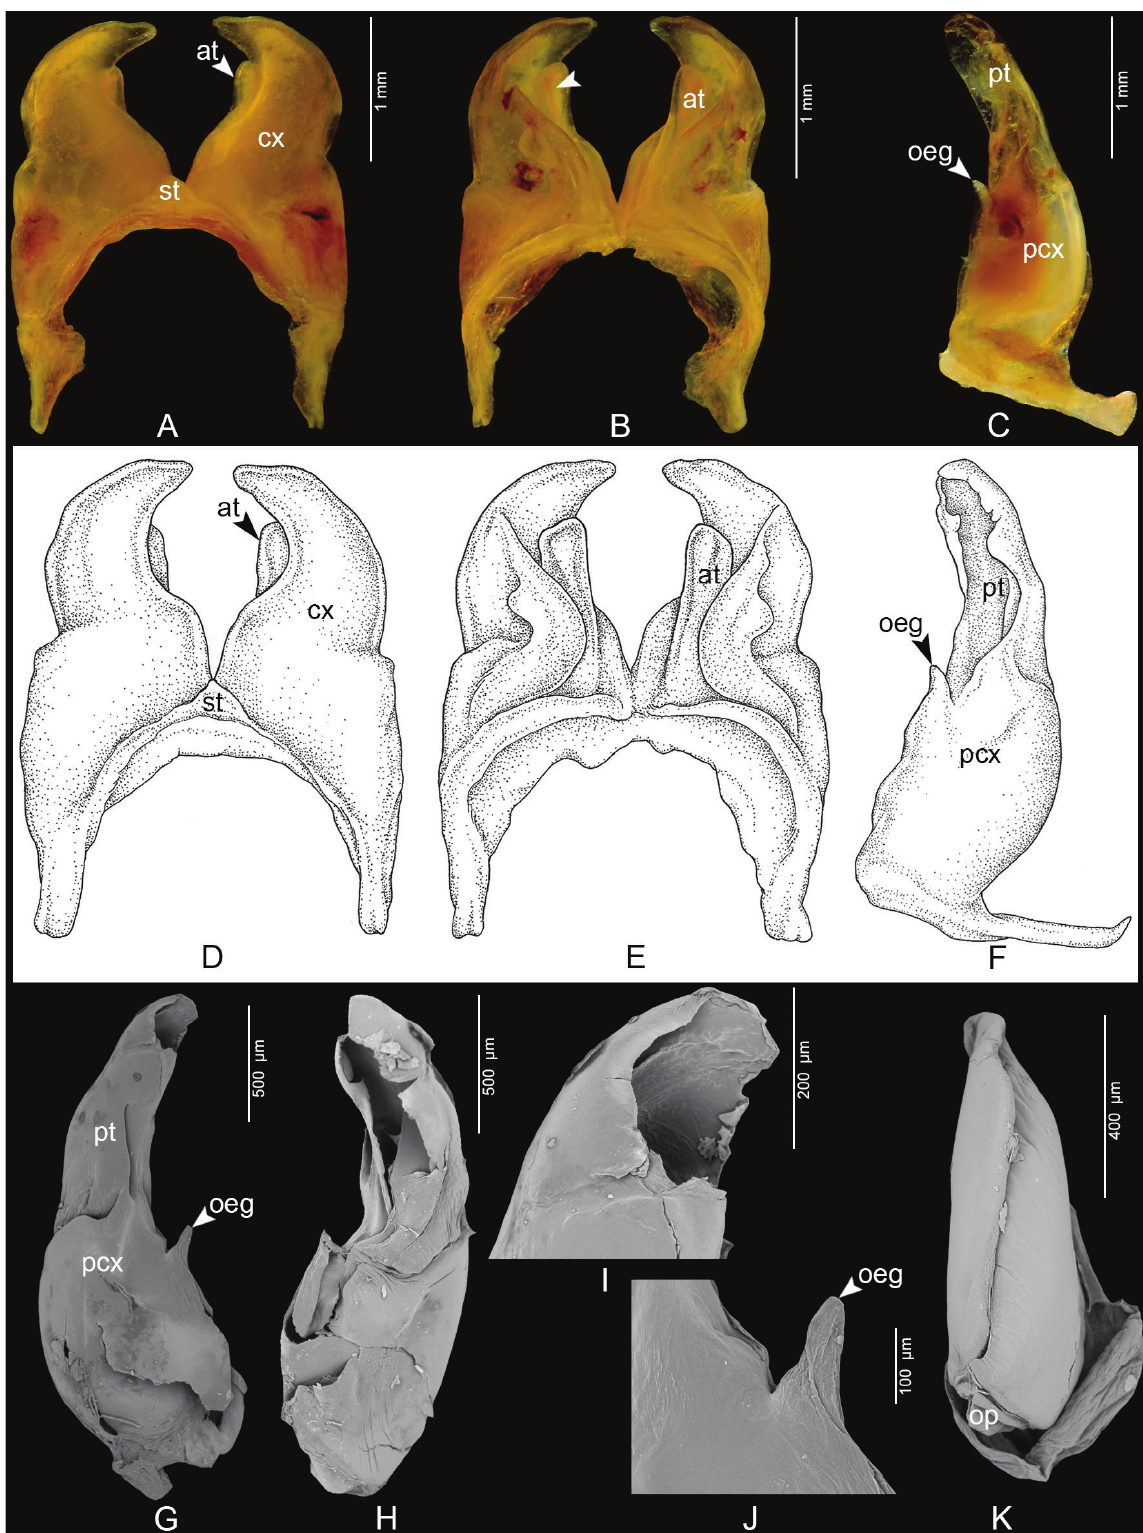
Figure 4. Siliquobolellus constrictus gen. et sp. nov., holotype, gonopods (specimen from Ban Yang Chum, CUMZ-D00150-1). A. An- terior gonopod, anterior view; B. Anterior gonopod, posterior view, arrow indicates a thumb-like process, with longitudinal ridge; C. Right posterior gonopod, lateral view; D. Anterior gonopod, anterior view; E. Anterior gonopod, posterior view; F. Right posterior gonopod, lateral view; G. SEM, Left posterior gonopod, lateral view; H. SEM, Left posterior gonopod, latero-mesal view; I. SEM, tip of left posterior gonopod, latero-mesal view; J. SEM, Mesal part of left posterior gonopod, lateral view; K. SEM, left female vulva, posterior mesal view. at = anterior gonopod telopodite; cx = coxa; oeg = opening of efferent groove; op = operculum of vulva; pcx = coxal part of the posterior gonopod telopodite; pt = telopodital part of the posterior gonopod telopodite; st = sternal